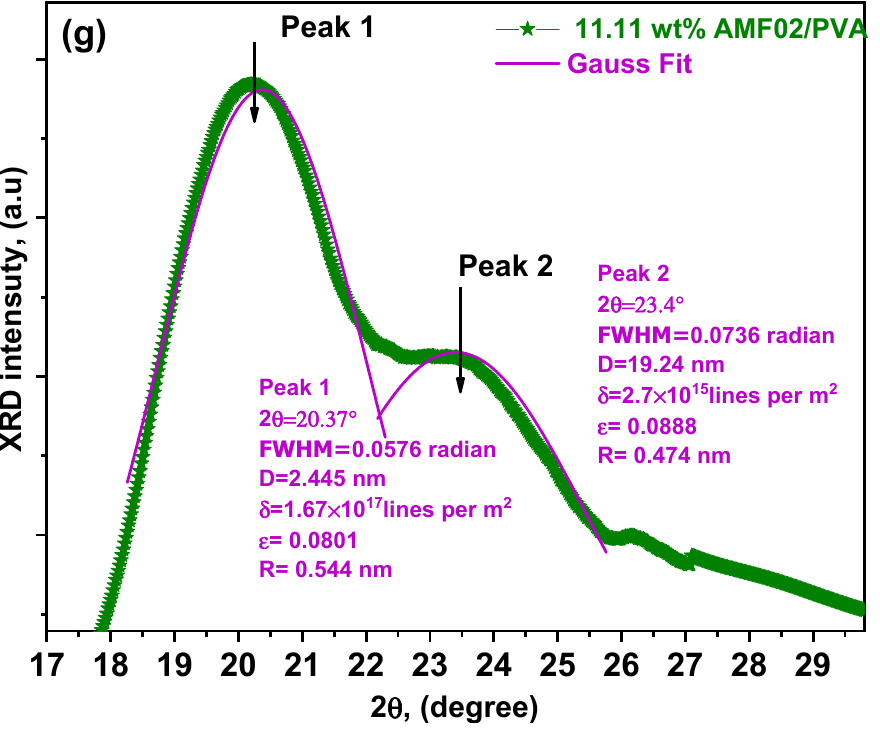
Figure 2. ( a – g ) Gauss fit diagrams for the mean peak of AMF02/PVA novel